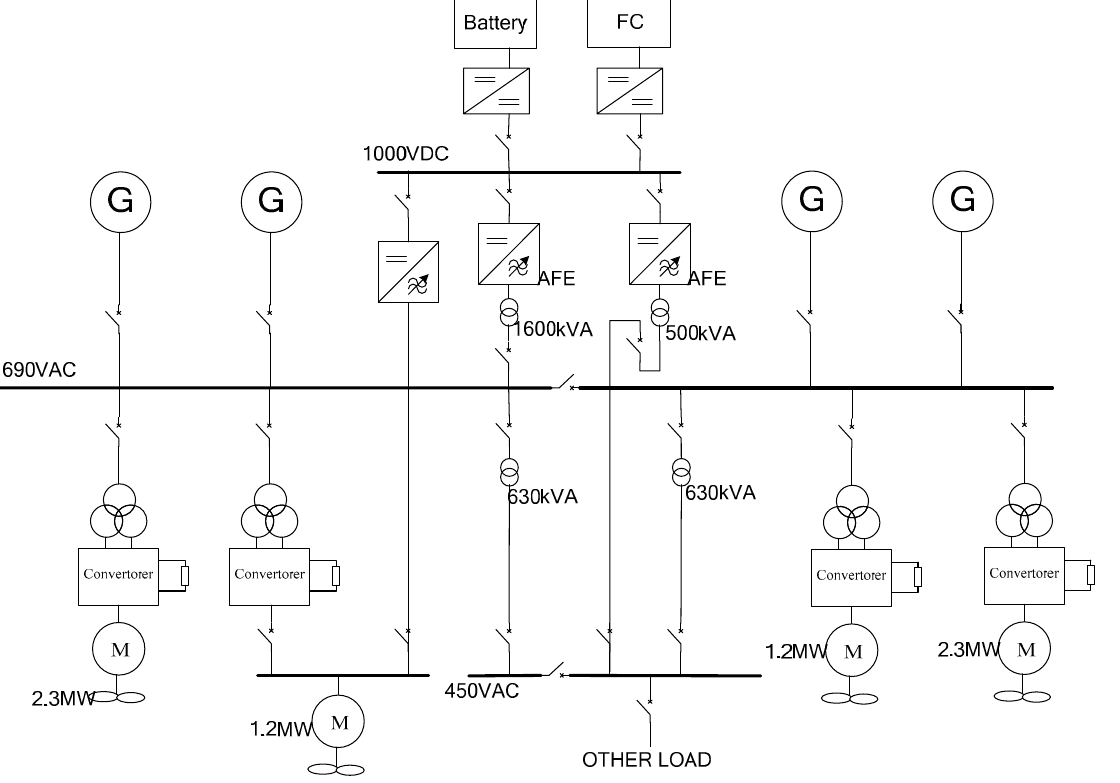
Figure 2. Fuel cells and batteries and generators hybrid system on Viking Lady.